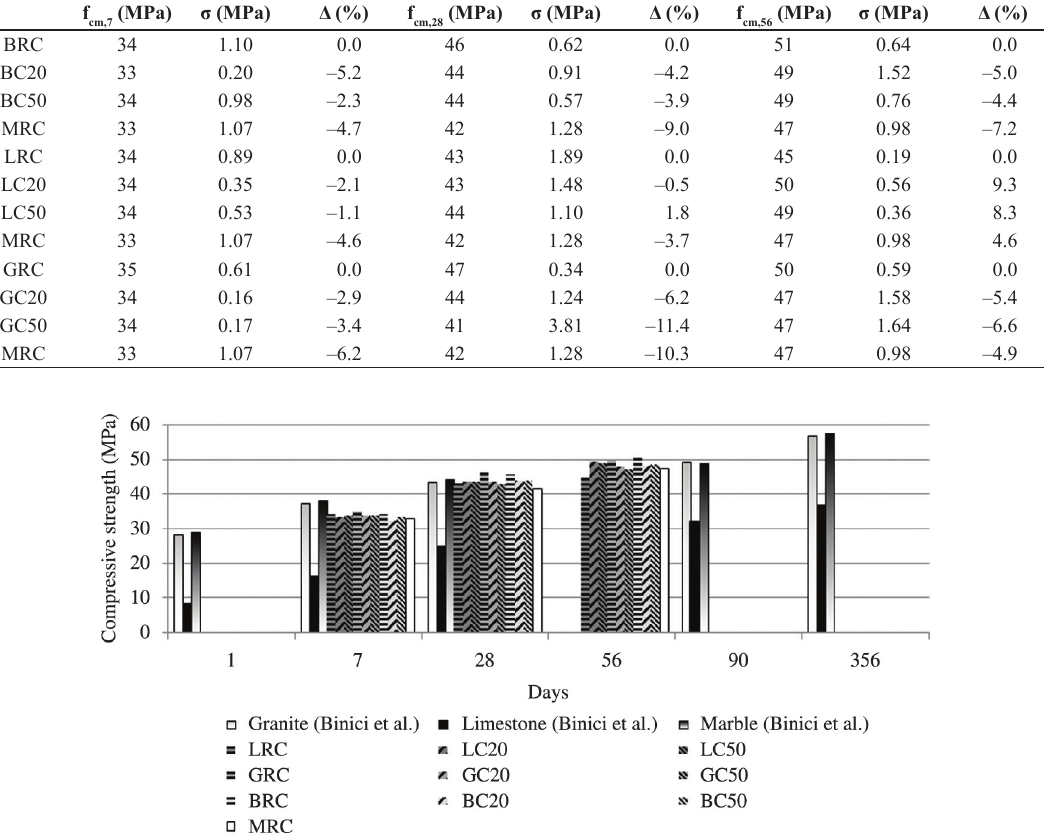
Figure 4. Compressive strength results: Binici et al. 6 vs. present